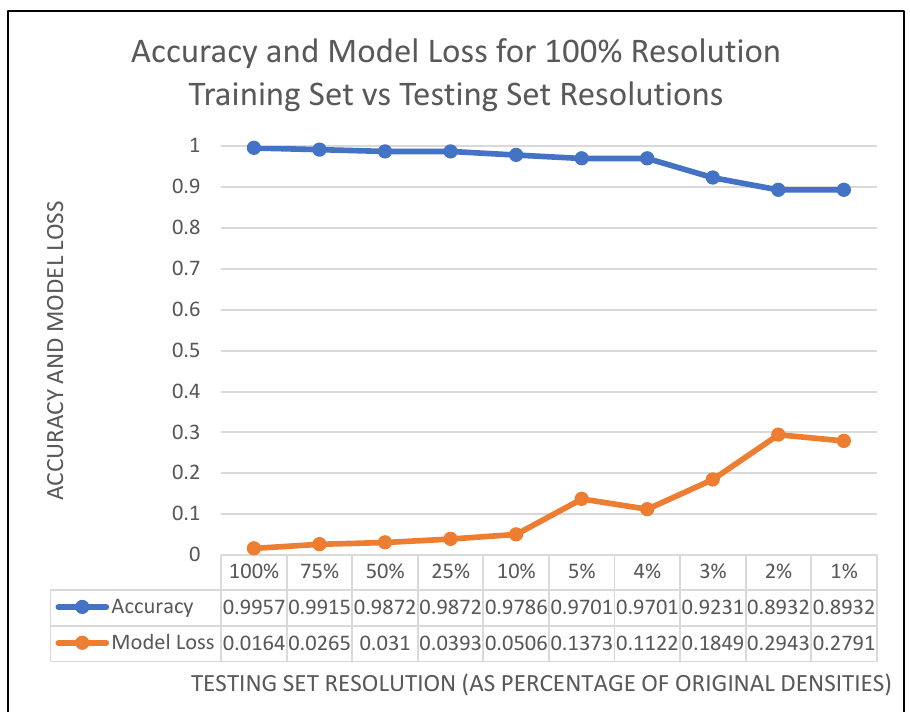
Figure 7. Accuracy and model loss on a model trained on 100% resolution data. The horizontal shows the testing set resolution as categories, and the y -axis is both accuracy and model loss on the testing set.